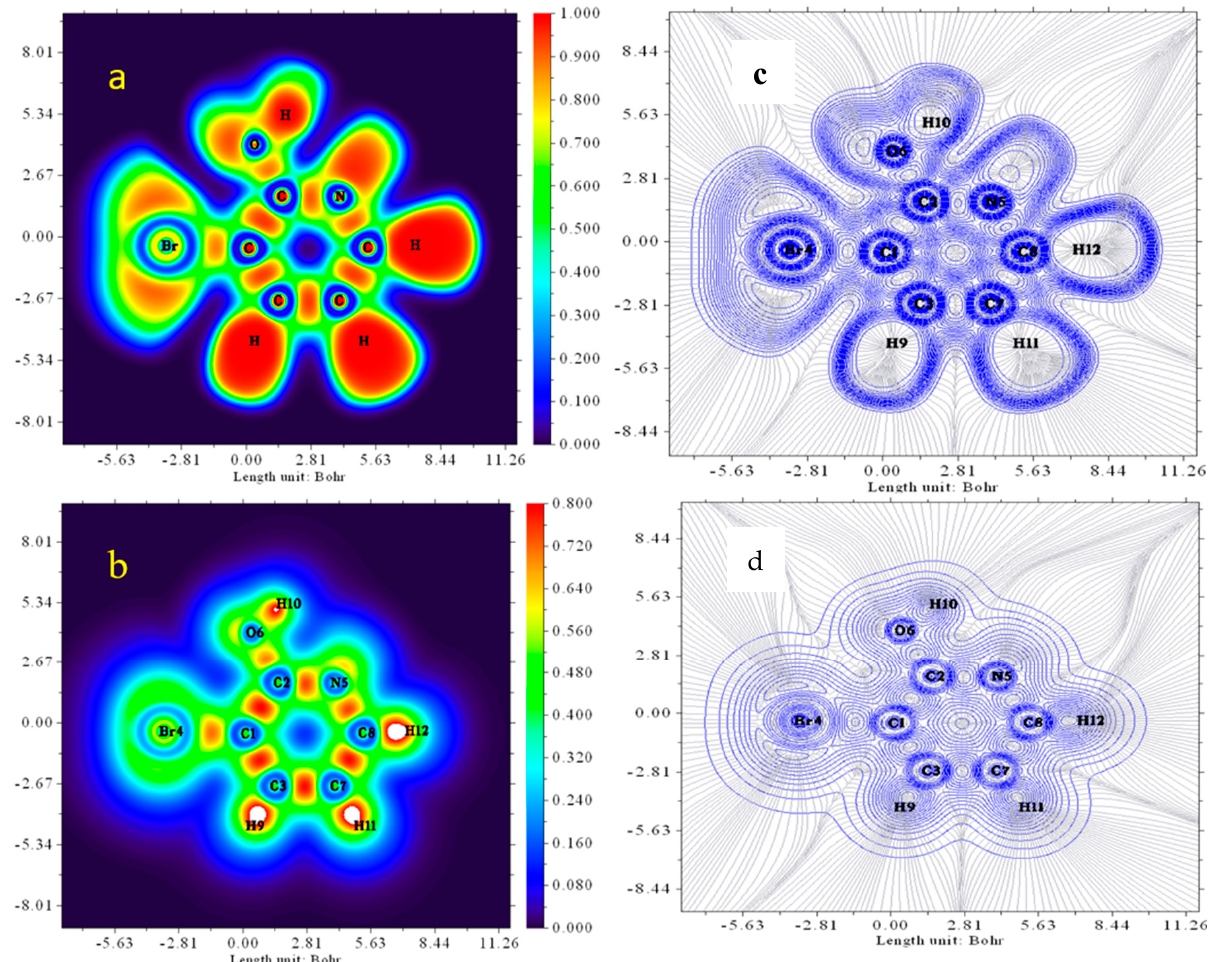
Figure 7. ELF ( a and c) and LOL ( b and d) of title compound. Figure 7. ELF ( a , c ) and LOL ( b , d ) of title